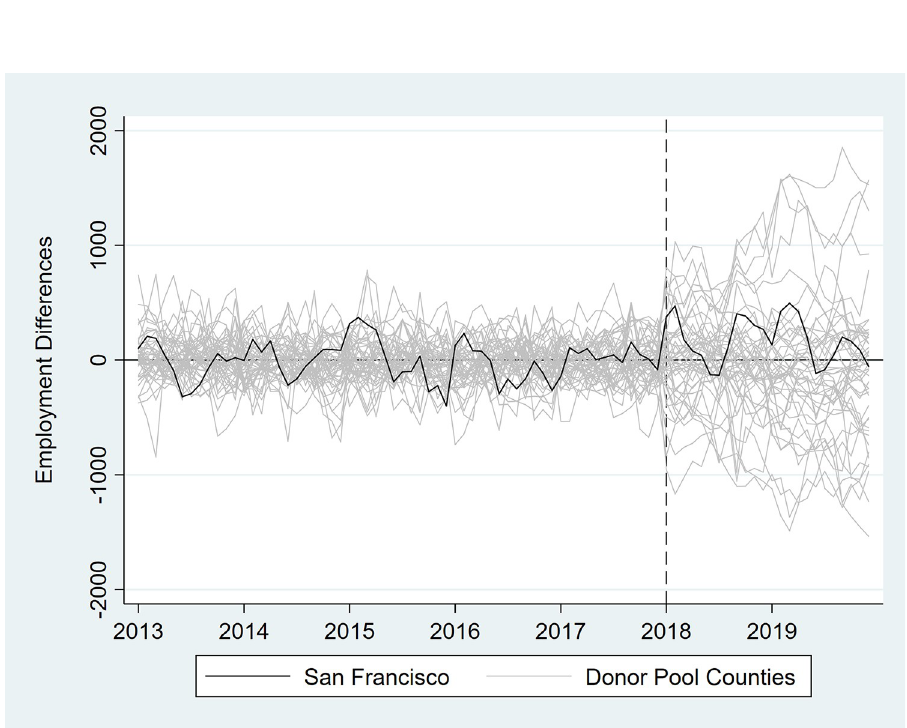
Fig 11. Differences in employment outcomes between each county and its synthetic control for limited-service restaurant employment.